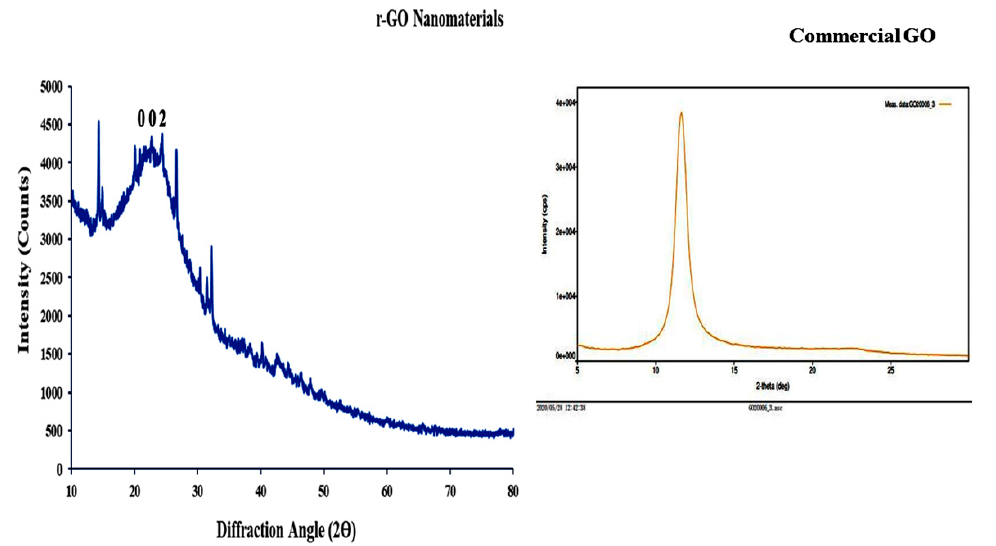
Figure 5. XRD analysis of reduced graphene oxide nanomaterial.